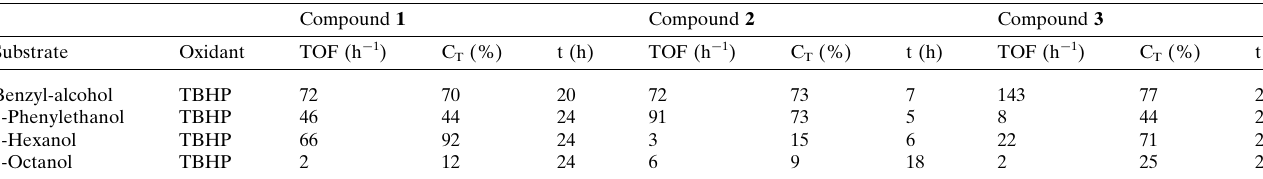
Table 2 Selective oxidation of several alcohols over catalysts 1, 2 and 3 . C T is the total